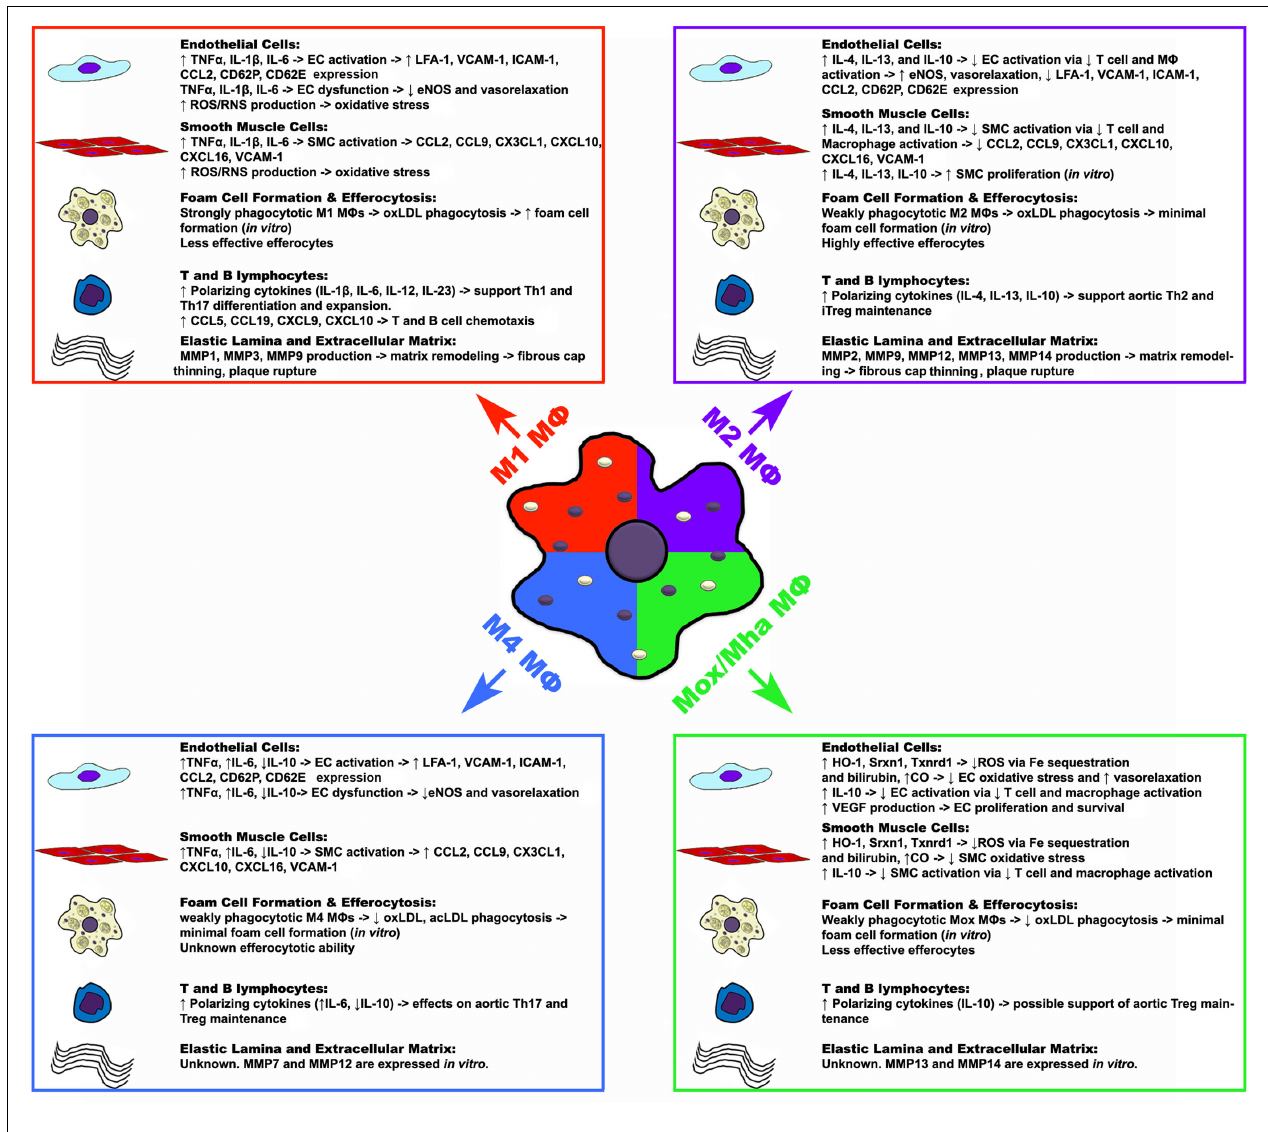
factors, and possible effects are listed in the box. ↑ , increase; ↓ , decrease; → , result or effect; CO, carbon monoxide; EC, endothelial cell; eNOS, endothelial nitric oxide synthase; HO-1, heme oxygenase-1; ICAM-1, intercellular adhesion molecule 1; M Φ , macrophage; MMP, matrix metalloproteinase; SMC, smooth muscle cell; Srxn1, sulfiredoxin 1 homolog;Txnrd1, thioredoxin reductase 1;VCAM-1, vascular cell adhesion molecule